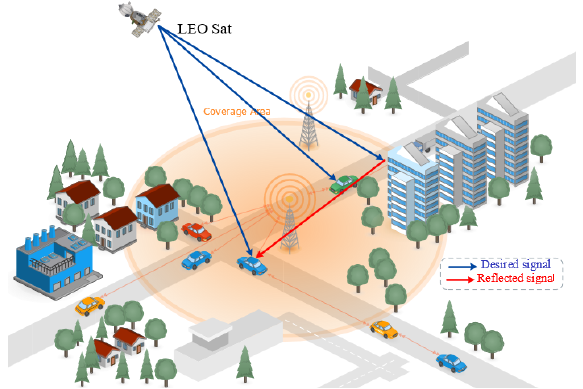
Figure 3. NLOS signal reflected from high buildings, towers, or